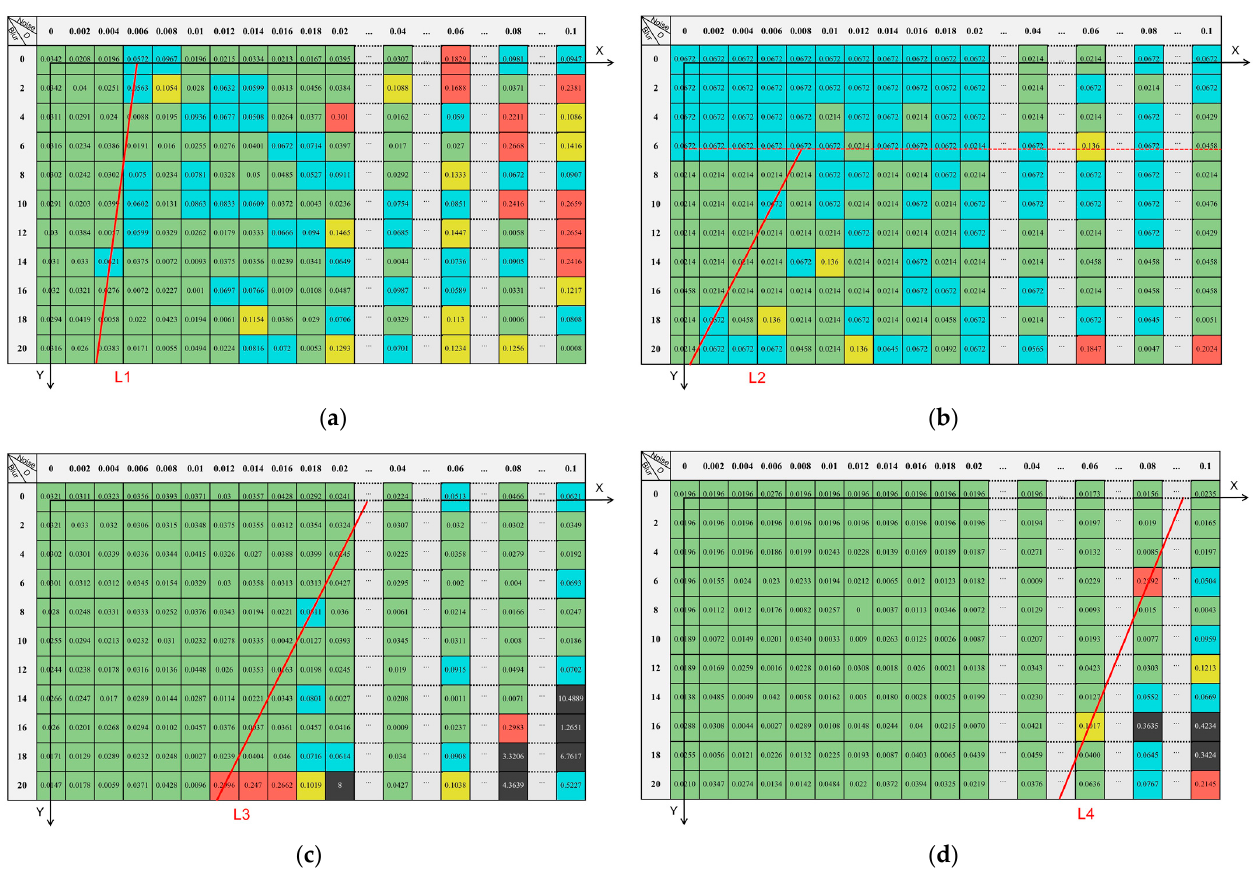
Figure 13. The results and demarcation line of each method: ( a ) detection results and demarcation line L1 of ISO 12233; ( b ) detection results and demarcation line L2 of Hough transform(The red dotted line is the value range of the demarcation line); ( c ) detection results and demarcation line L3 of LSD; ( d ) detection results and demarcation line L4 of this algorithm.